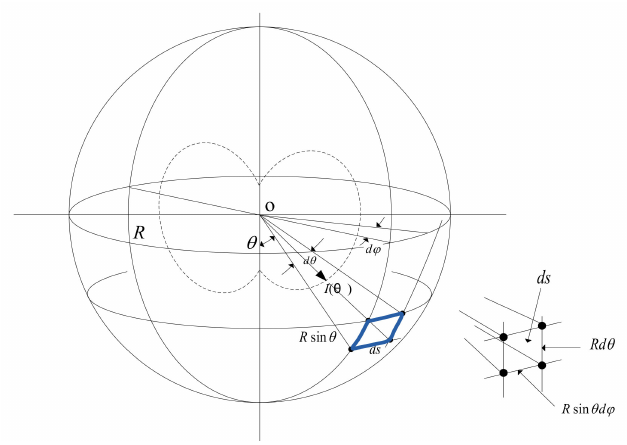
Figure 2. Zonal flux calculation of a 3D